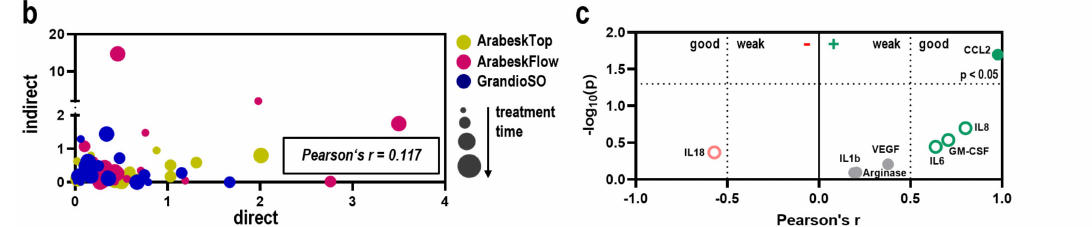
Figure 5. Cellular secretion profiles of gas plasma-treated composite chips. ( a ) levels of 13 different cytokines and chemokines in cellular supernatants 24 h after onset of human HaCaT cultures on gas plasma-treated (30 s, 60 s, 120 s), hydrogen peroxide (H 2 O 2 )-spiked composite chips (direct), or human HaCaT cells cultured in the absence of composite chips but in the presence of cell-culture medium previously incubated with untreated or gas plasma-treated composite chips (indirect), normalized to untreated conditions (0); ( b ) Pearson’s correlation analysis of treatment mode (absolute direct vs. indirect fold changes in positive numbers of better visualization) for the three composite types and gas plasma treatment times used in this study; ( c ) Pearson’s correlation analysis of absolute chemokine and cytokine levels of the direct treatment regimen supernatants with metabolic activity data at 24 h of the direct treatment regimen. Data are mean of four technical replicates pooled from six independent experiments with three technical replicates each.